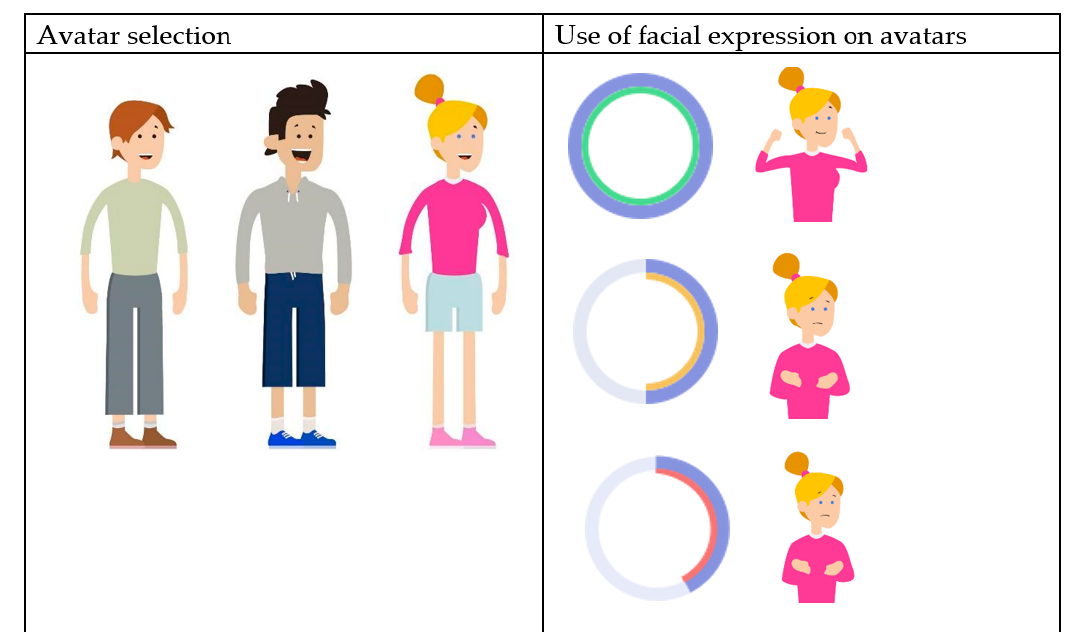
Figure 5. Use of avatars in INK.